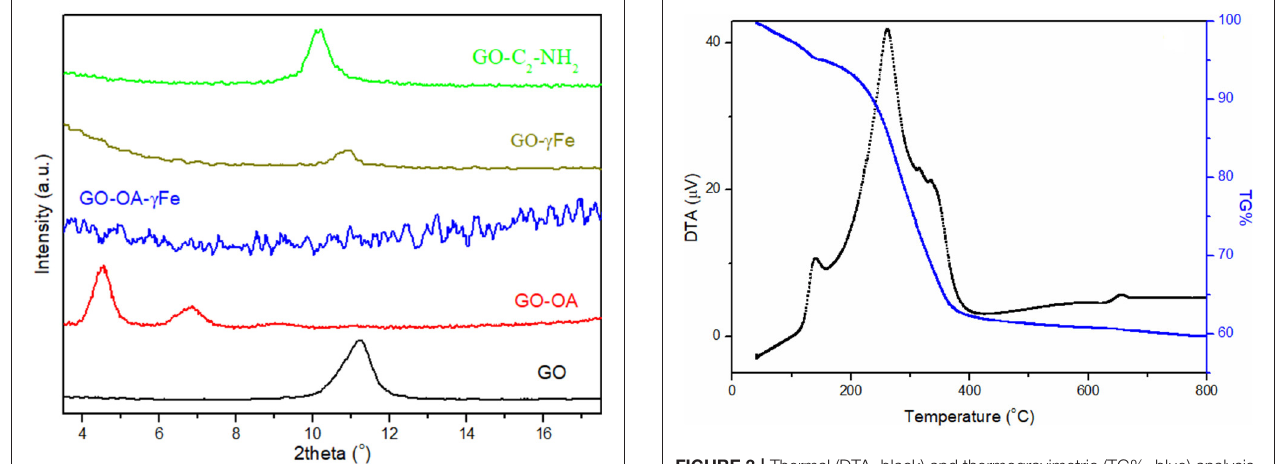
is seen to have shifted to lower angles. More specifically 4.5 ◦